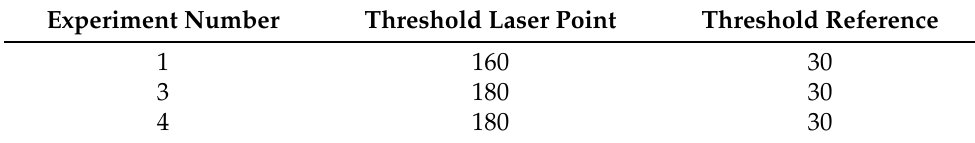
Table 1. Thresholds used by the image processing algorithm for each